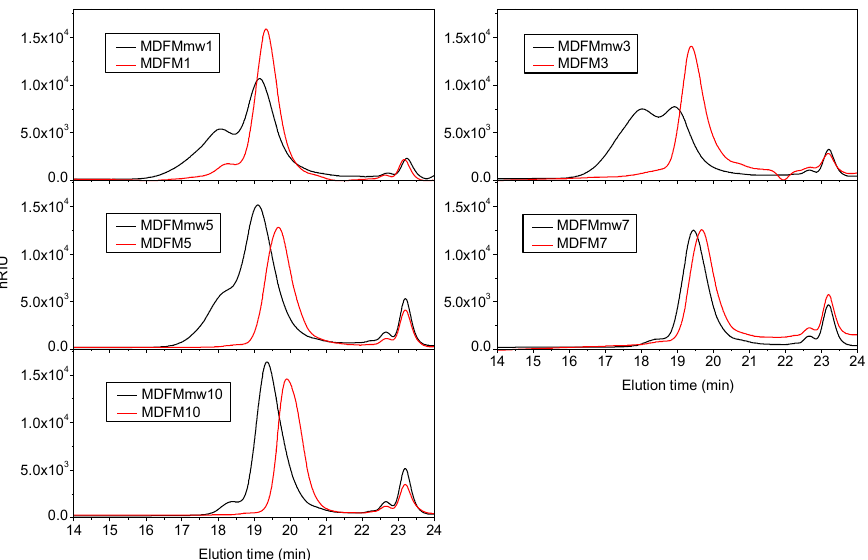
Figure 13. Comparison between chromatograms collected during SEC analysis of the macromolecular dyes samples prepared by microwave-assisted polymerization of L-lactide and by using 1–10 mol% of FM (MDFMmw1–MDFMmw10) and MDFM1–MDFM10.